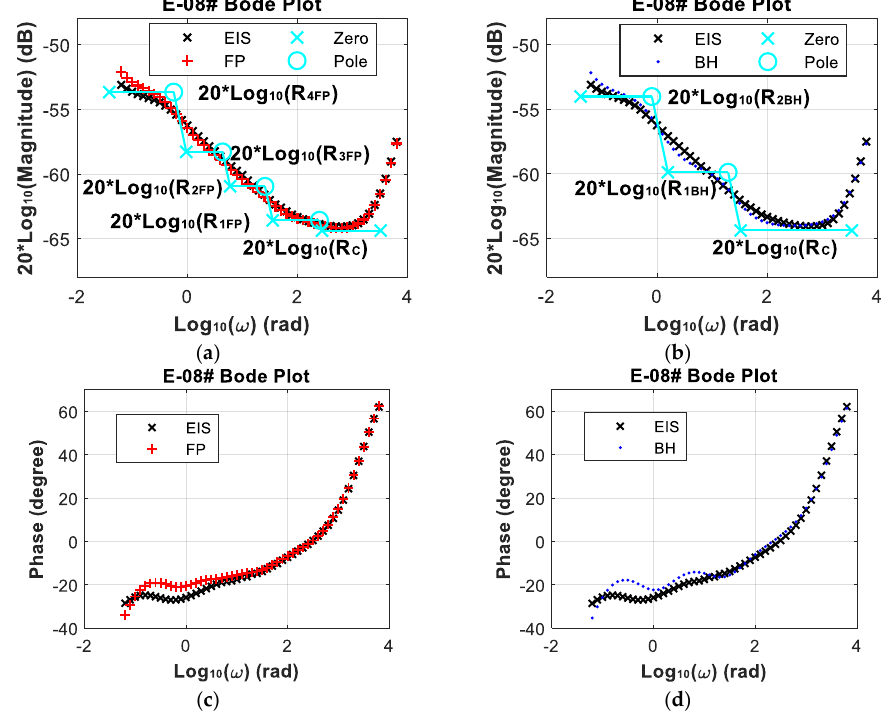
Figure 13. Linear circuits fitting for bode plots: ( a ) FPLC ACequ fitting in magnitude; ( b ) BHLC ACequ fitting in magnitude; ( c ) FPLC ACequ fitting in phase; ( d ) BHLC ACequ fitting in phase.